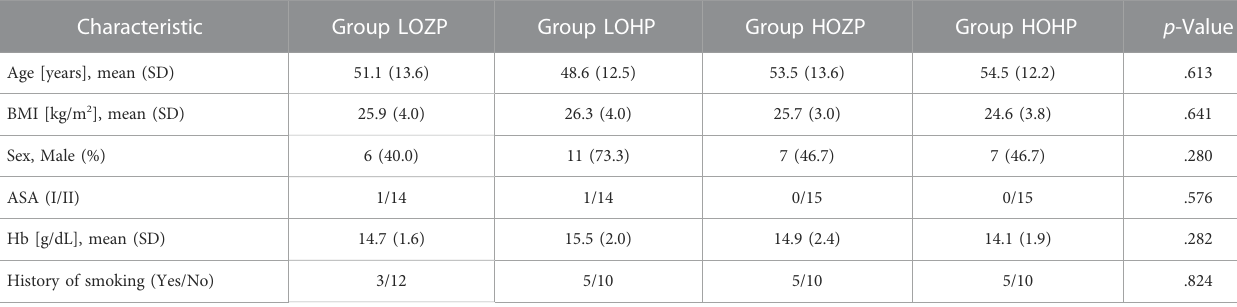
TABLE 1 Patient characteristics.